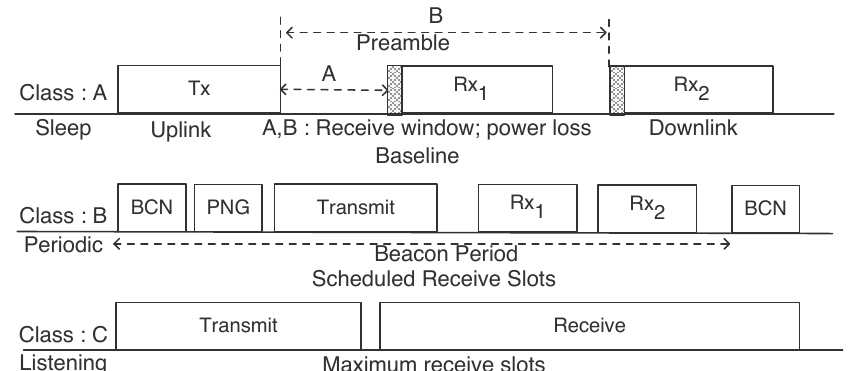
Figure 7. LoRaWAN device